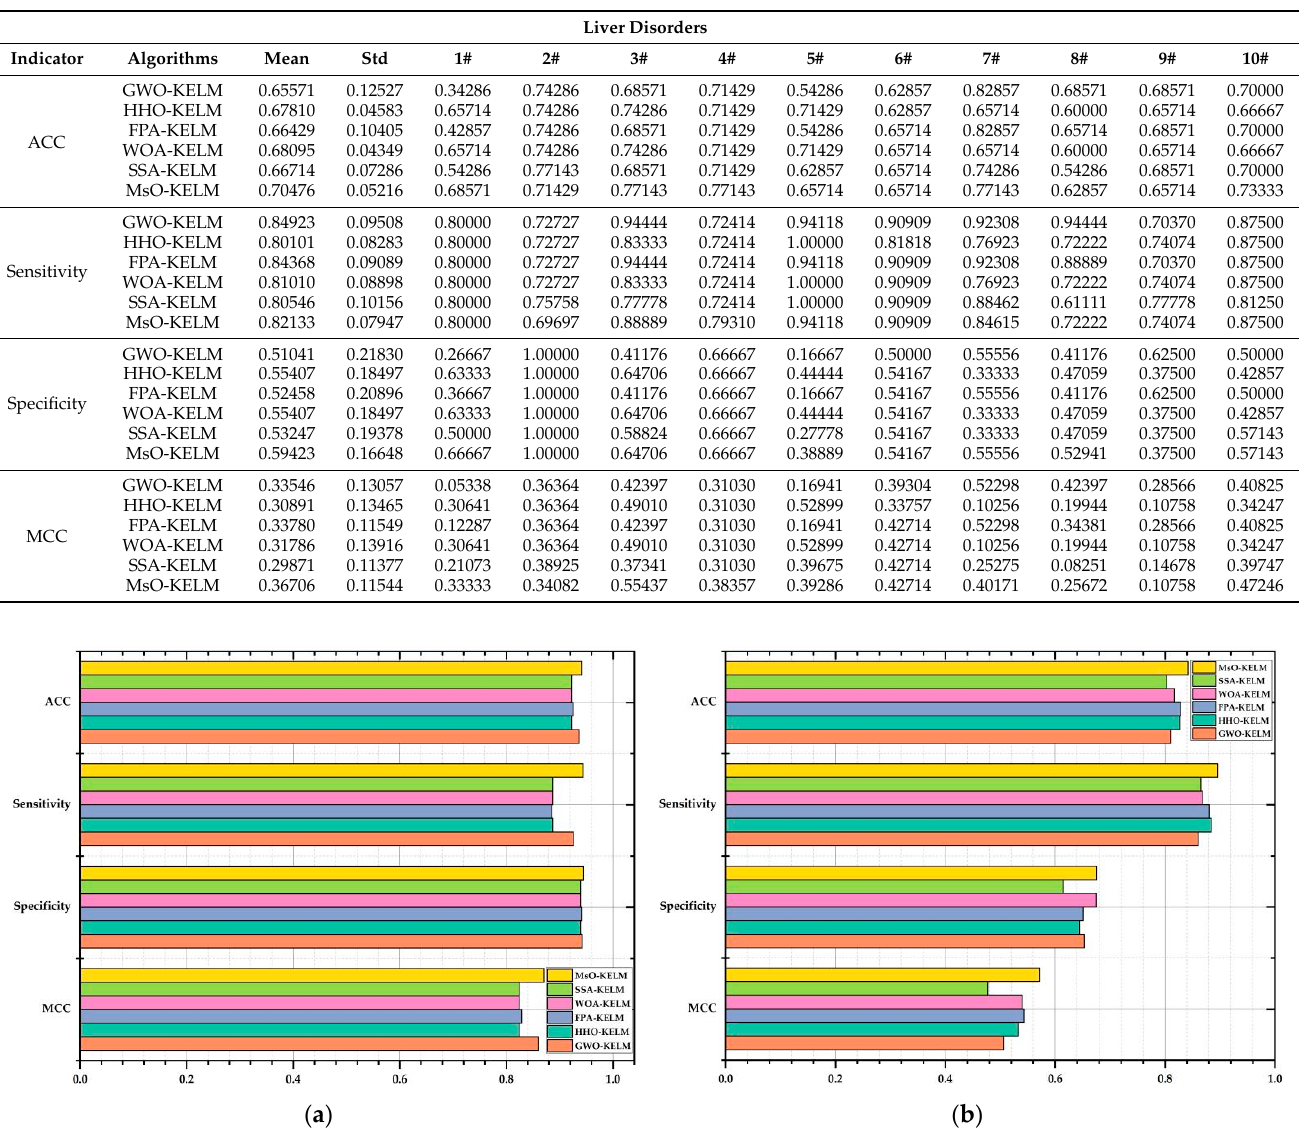
Table 11. The prediction results on disease dataset Bupa.